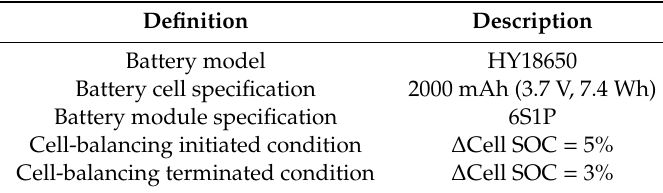
Table 8. Experimental specifications for the PCB method with HY18650.